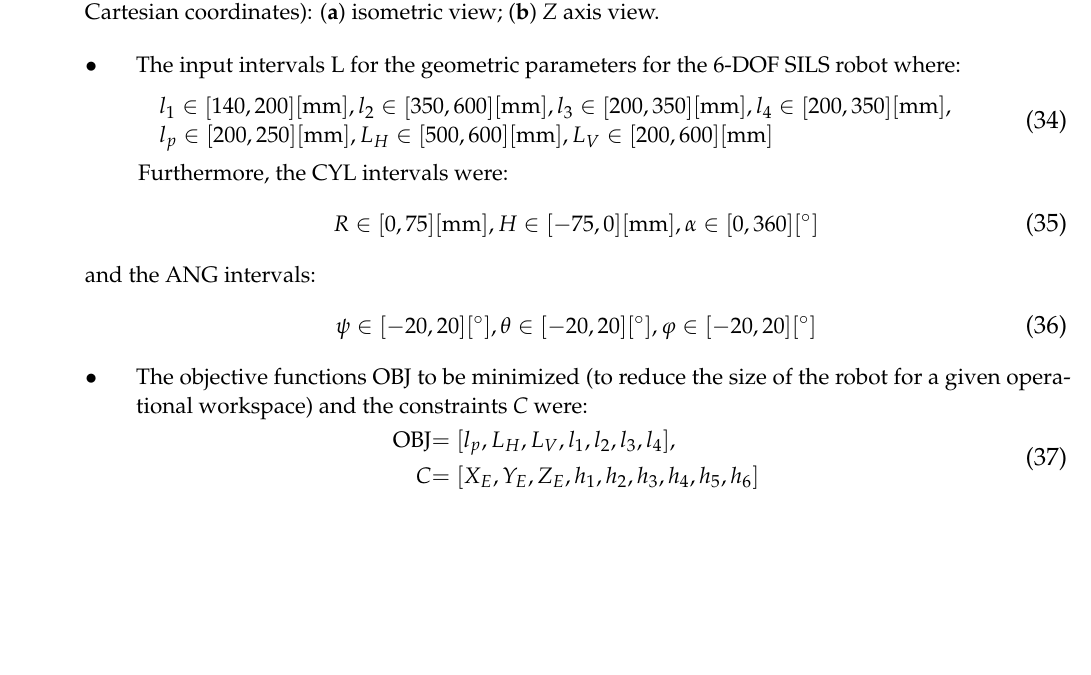
Figure 14. The generated discrete workspace (WS_DATA) for the SILS robotic systems (only the Cartesian coordinates): ( a ) isometric view; ( b ) Z axis